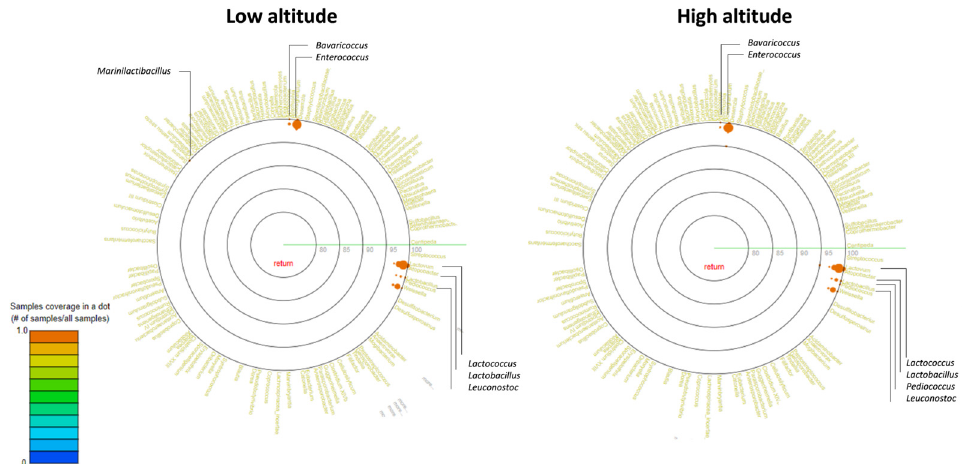
Figure 8. Abundance of bacterial groups from different altitudes employing the VITCOMIC circular diagram. Presence of LAB at low altitude (up to 150 m), medium (>150 and <350 m), and high (>350 m) was derived from the average altitude of Rio Grande do Sul State (206 m).